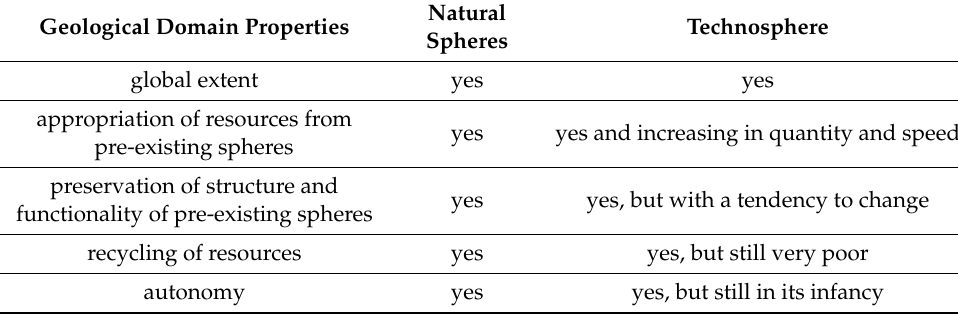
Table 1. Summary of the properties of the geological